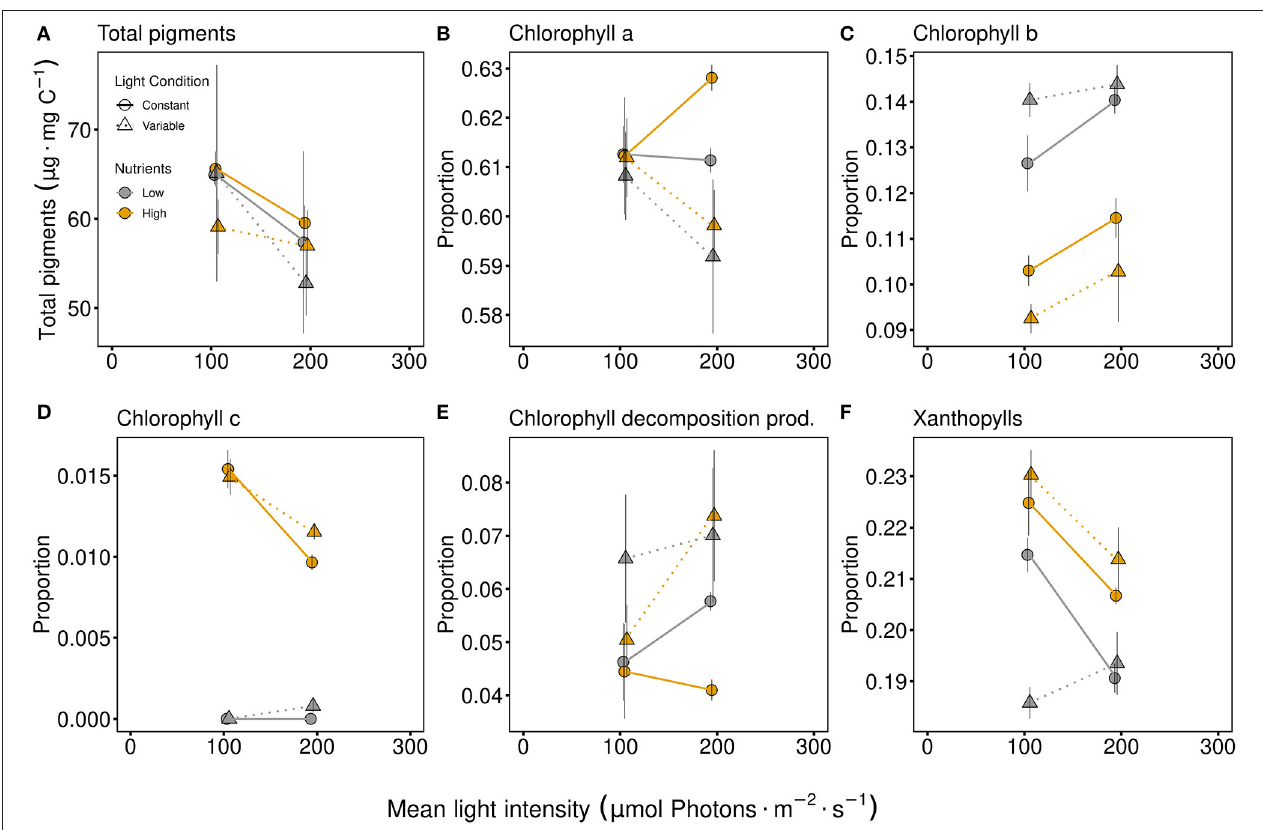
FIGURE 2 | Total pigment content [ µ g Pigments per mg carbon; (A) ] and proportions of specific chlorophylls (B–D) , as well as chlorophyll decomposition products [Chlorophyll decomposition prod., (E) ] and xanthophylls (F) . Communities were either cultivated under variable (triangles, dashed line) or constant (circles, solid line) light conditions. Mean values are shown for high (orange symbols and lines) and low (gray symbols and lines) nutrient supply and are displayed with ± standard error. Pigment proportions in more detail are shown in Supplementary Figure 5